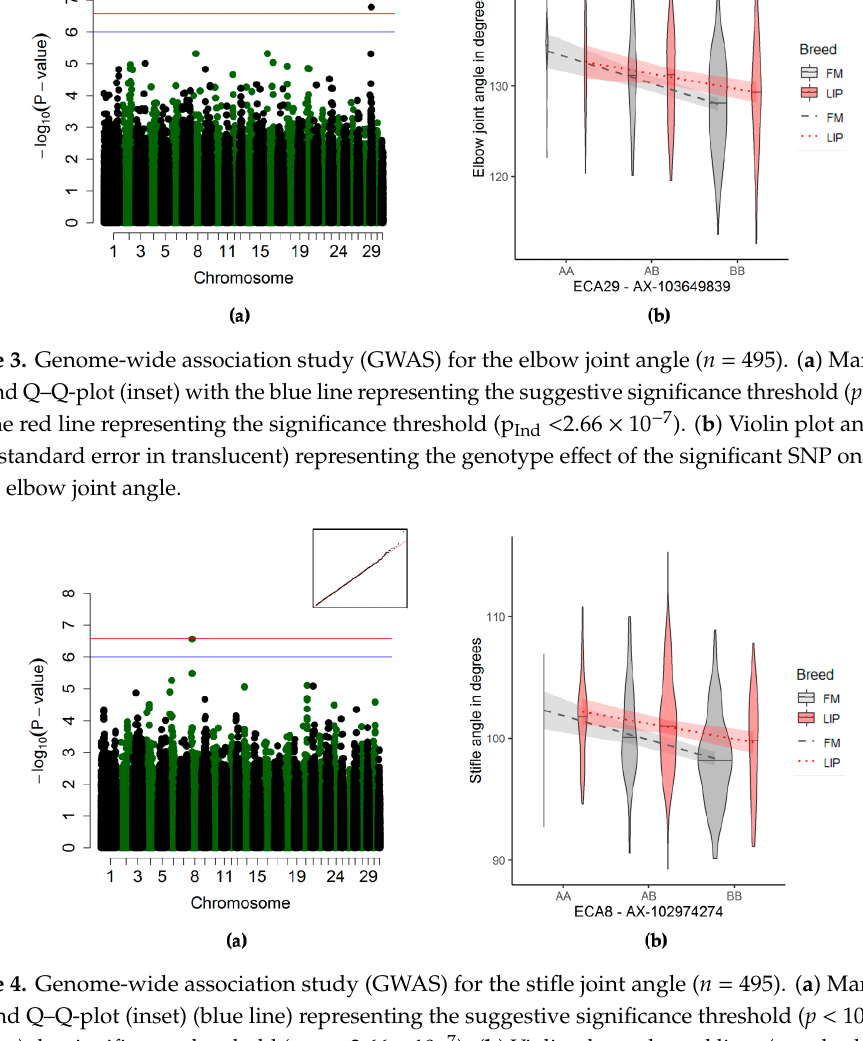
Figure 5. Genome-wide association study (GWAS) for the fetlock joint angle of the hind limb ( n = 495). (a) Manhattan plot and Q–Q-plot (inset) (blue line) representing the suggestive significance threshold ( p < 10 − 6 ) and (red line) the significance threshold (p Ind <2.66 × 10 − 7 ). (b) Violin plot and trend lines (standard error in translucent) representing the genotype effect of the significant SNP on ECA27 on the elbow joint angle.